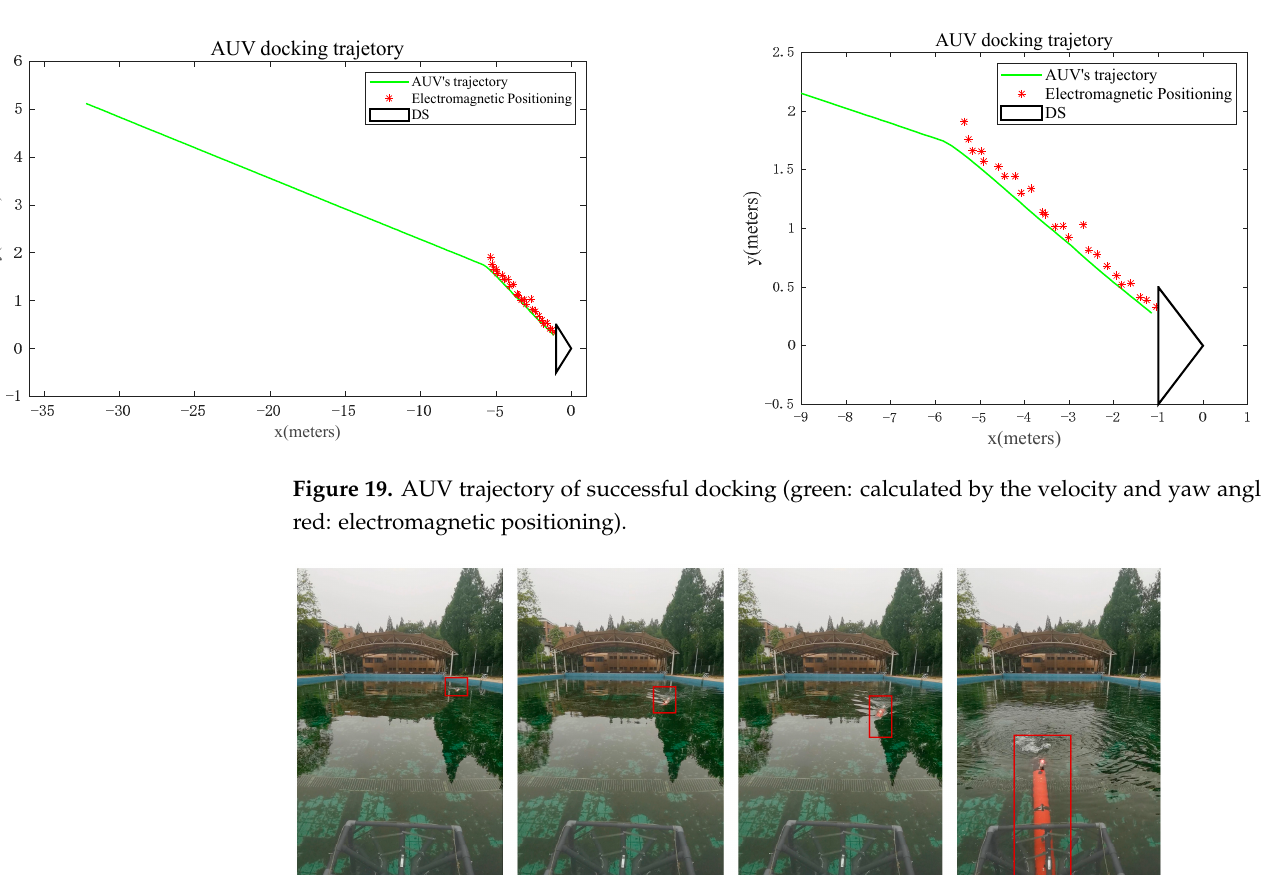
Figure 18. The DS and AUV with an electromagnetic guidance module in the docking experiment.